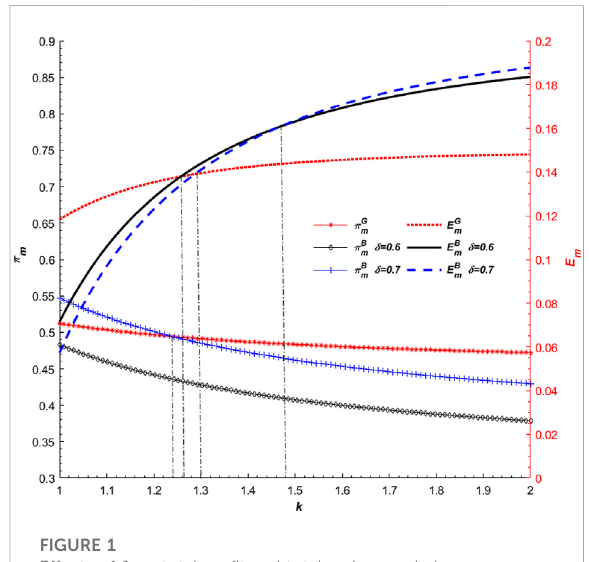
FIGURE 1 Effects of δ on total pro fi t and total carbon emissions. FIGURE 2